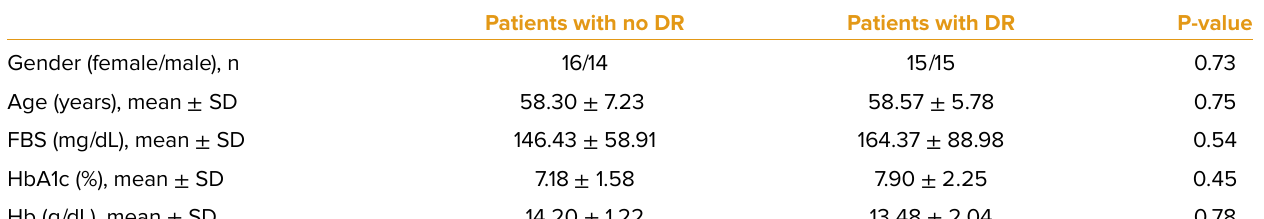
Patients with no DR Patients with DR P-value